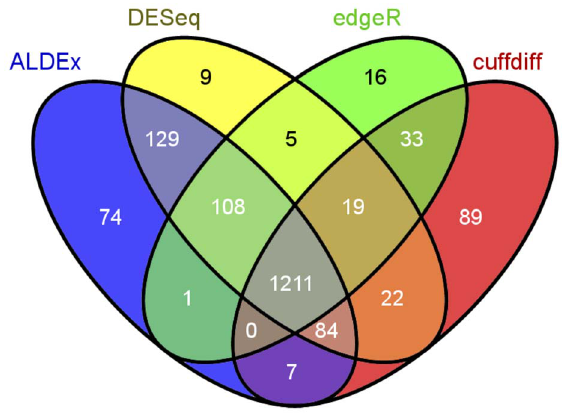
Figure 6. Venn diagram of the four differential expression methods in the B. cereus dataset. Transcript abundances were identified as differential as in Figure 5. The overlap between the number of differentially expressed transcripts for each method is given in the individual cells of the diagram. The number of differentially regulated transcripts for each method is: ALDEx 1614, DESeq 1587, edgeR 1393, CuffDiff 1465. The diagram was prepared using the Venny web tool(Available: http://bioinfogp.cnb.csic.es/tools/venny. Accessed